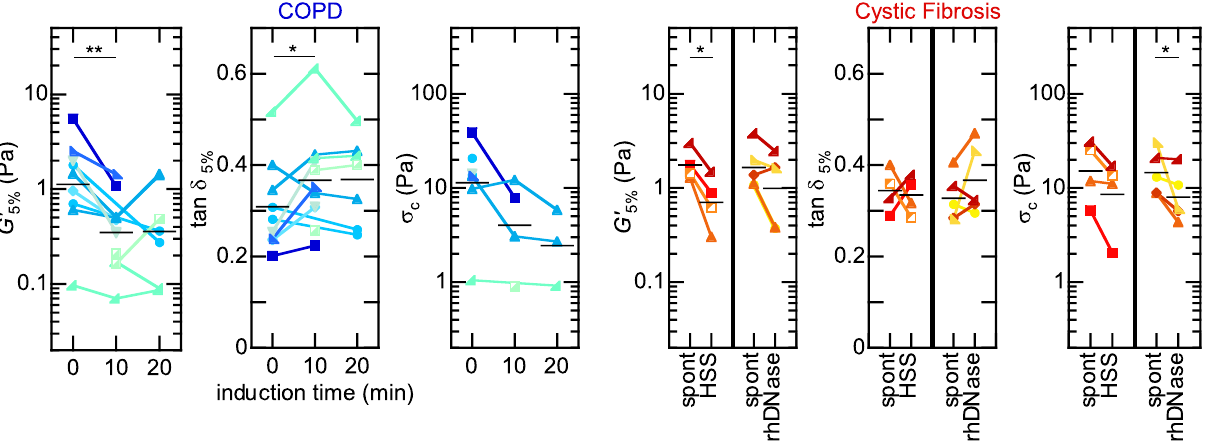
Figure 3. Effect of induction on sputum rheology. Left: Evolution of the linear storage modulus, G ′ 5% , damping 0 , spontaneous expectoration) and after nebulisation of 4.5% ratio, tan δ 5% , and critical stress, σ c , before ( t = HSS, for individual COPD patients. Right: Same rheological parameters, comparing spontaneous expectoration to 4.5% HSS nebulisation (10 min) and to 2.5 mL rhDNase in CF patients. Each connected group of symbols corresponds to consecutive sputum samples collected from the same individual patient; each symbol is a mean over consecutive replicates when available. Horizontal bars: geometric ( G ′ , σ c ) or arithmetic ( tan δ ) mean over the corresponding populations. * p < 0.05 ; ** p < 0.01